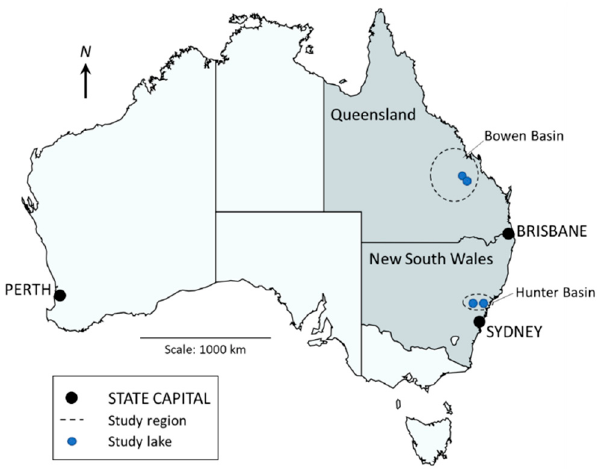
Figure 1. Map of Australia showing approximate location of study lakes in the Bowen Basin, Queensland and the Hunter Basin, New South Wales.